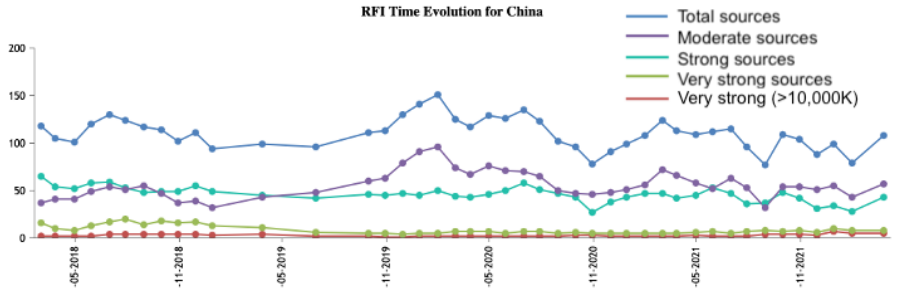
Figure 9. Plot of number or RFI depending on time and RFI strength in China.